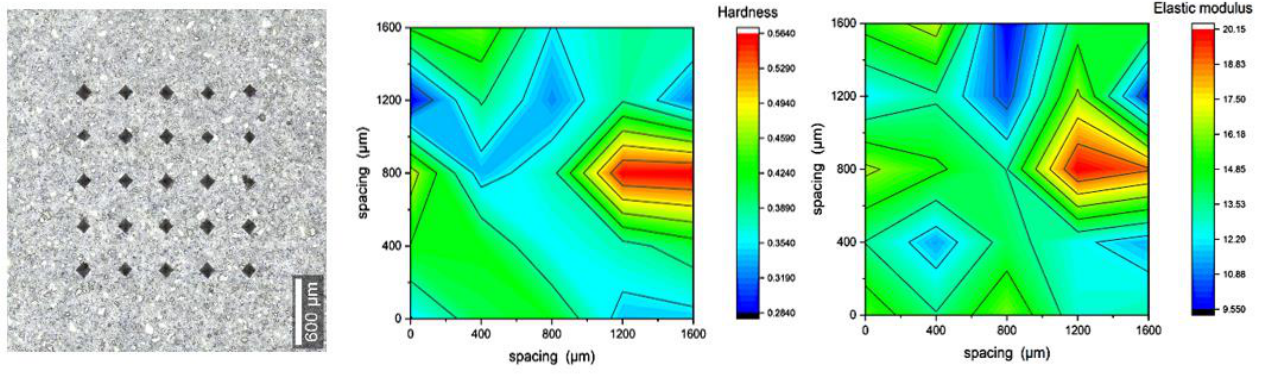
Figure 10. Indentation results for polished cores of 5% ferrierite-added Class-H cement with 25 in- dents, represented as maps of hardness (avg. of 0.394 GPa) and elastic modulus (avg. of 14.03 GPa).